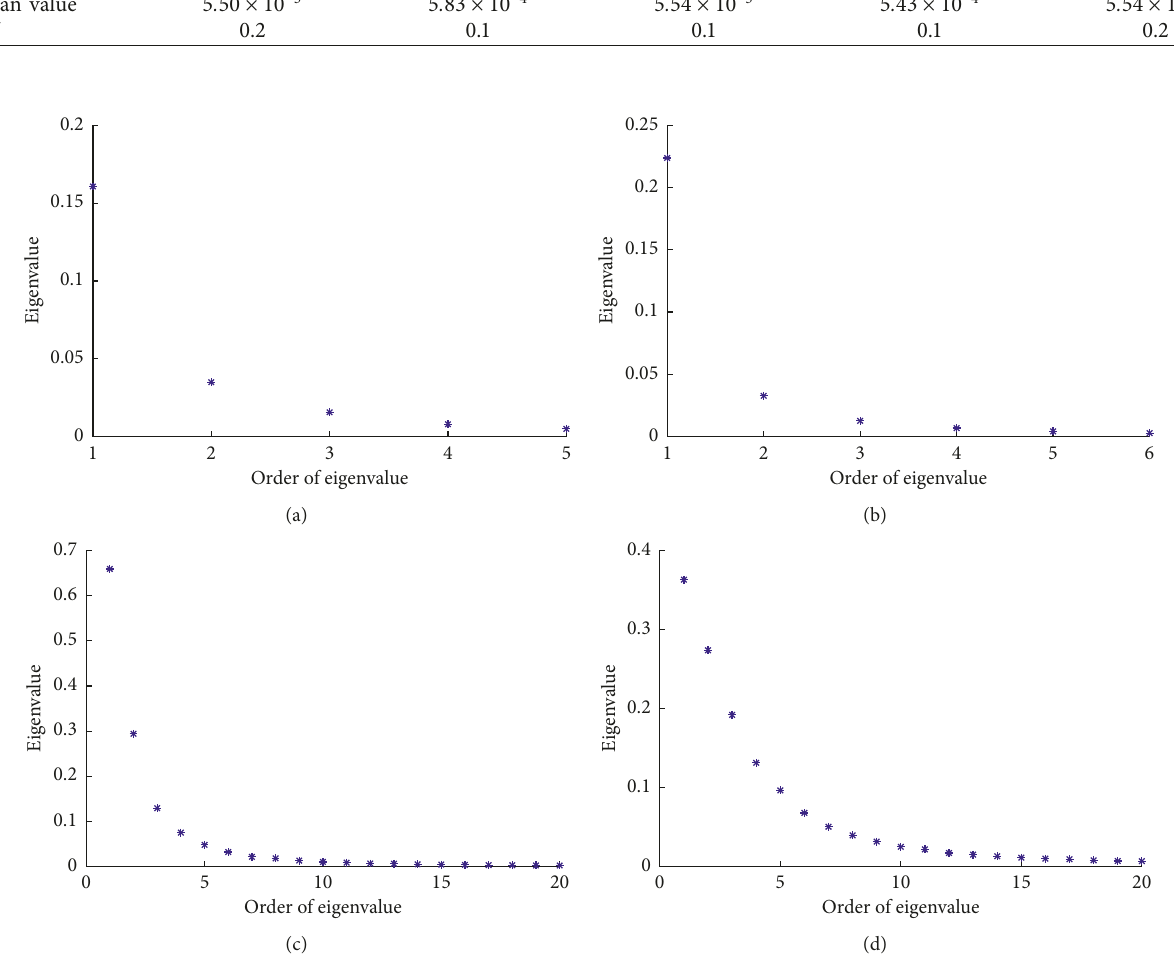
Figure 4: Eigenvalues calculated from the Fredholm equation with the different correlation times of (a) 4 weeks, (b) 2 weeks, (c) 0.5 weeks, and (d) 0.2